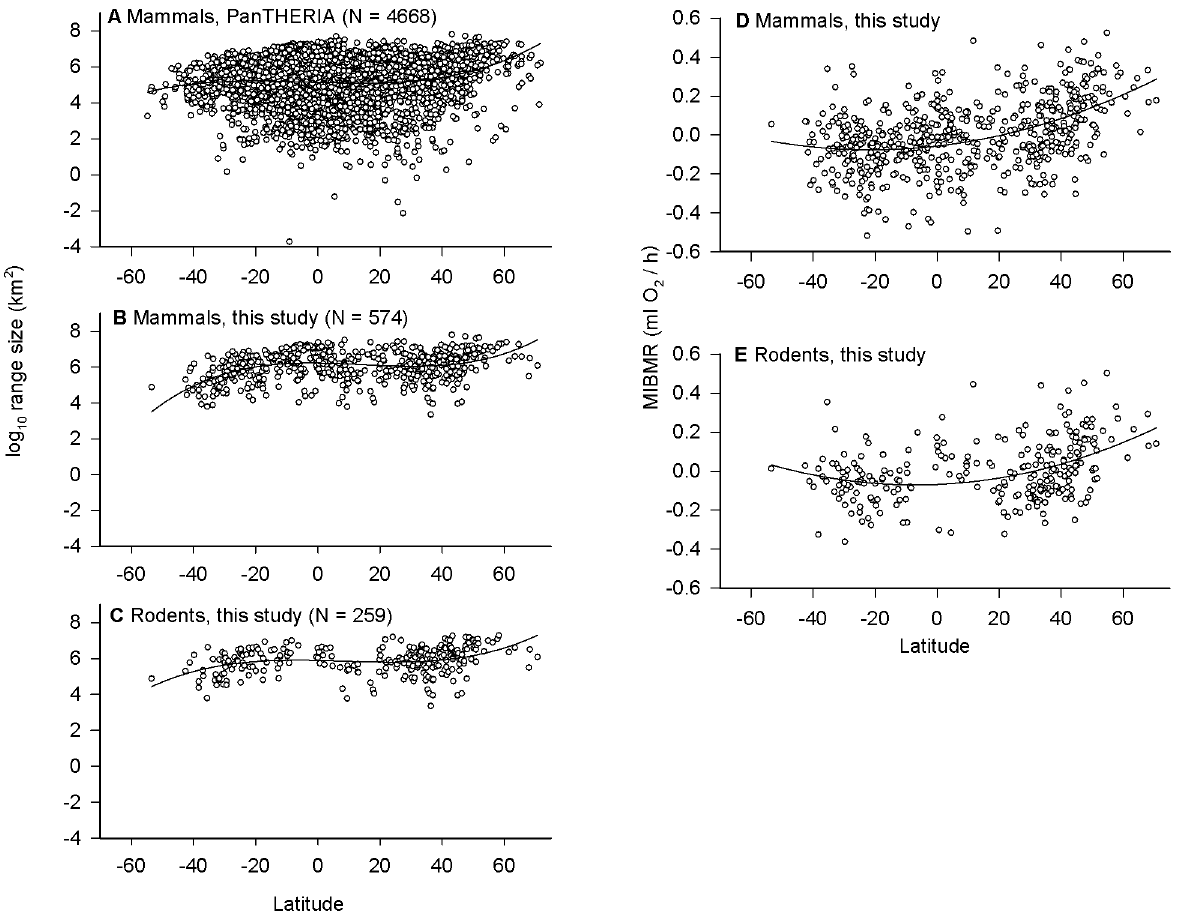
Figure 2. Latitudinal trends in (a-c) geographic range size and (d, e) mass-independent basal metabolic rate (MIBMR) for various mammal datasets. Points along the x-axis represent the latitudinal midpoint of a species’ geographic range. Significant relationships are indicated by OLS regression lines-of-best-fit. Positive latitudes represent the Northern hemisphere; negative latitudes represent the Southern